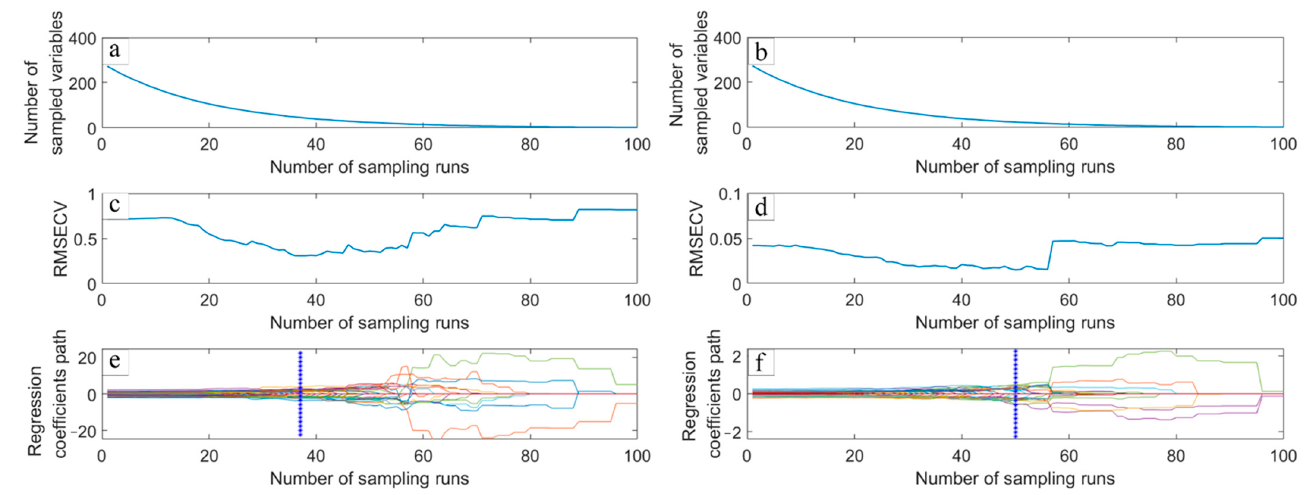
Figure 3. CARS variable selection of Hengyang, Baoding samples set using prior spectral bands of NSS Cd : Left-hand column ( a , c , e ) and right-hand column ( b , d , f ) show the results of Hengyang and Baoding samples set. ( a , b ) show the number of sampled variables; ( c , d ) the RMSECV; and ( e , f ) the regression coefficients path.